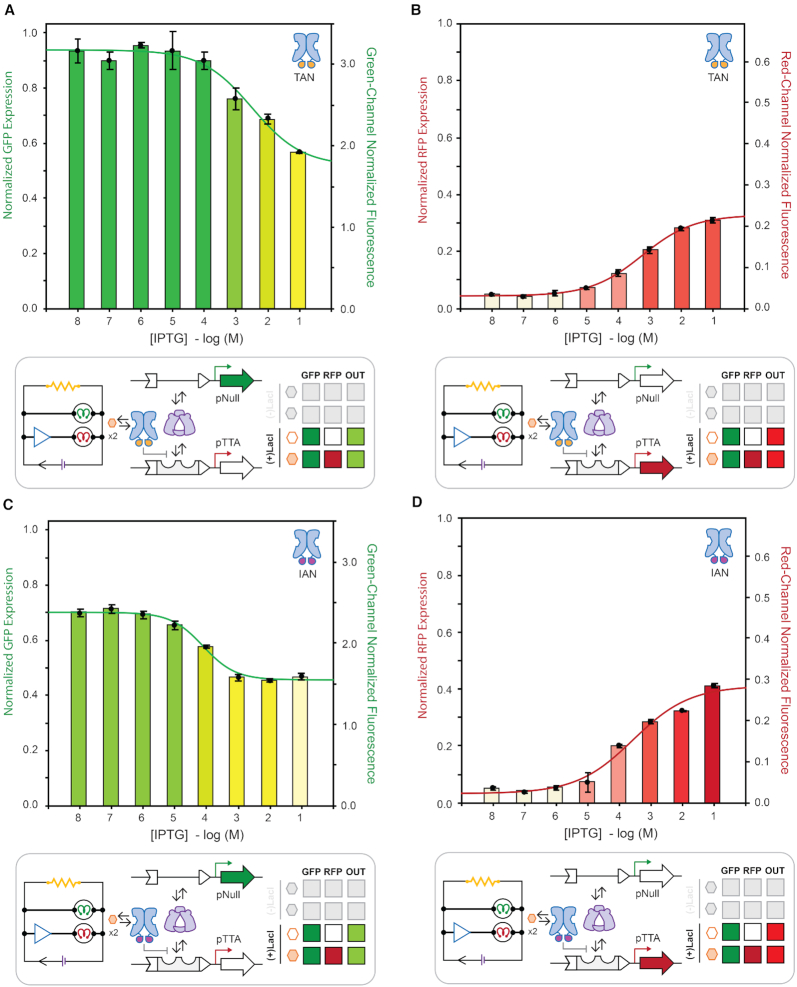
Inducer titration isotherms comparing coupled constitutive GFP expression using pNull and inducible RFP expression using pTTA at steady-state (t = 20 hours) under alternate DNA binding domain LacI regulation. GFP (A) and RFP (B) expression regulated using LacI variant Y17T/Q18A/R22N (TAN). GFP (C) and RFP (D) expression regulated using LacI variant Y17I/Q18A/R22N (IAN). Fluorescence from green (λex = 485 nm, λem = 510 nm, gain = 400) and red (λex = 585 nm, λem = 610 nm, gain = 400) channels normalized by culture density (λabs = 600 nm), and reported as the fraction of total potential fluorescence as well as × 104 relative fluorescence units, on left and right vertical axes, respectively.